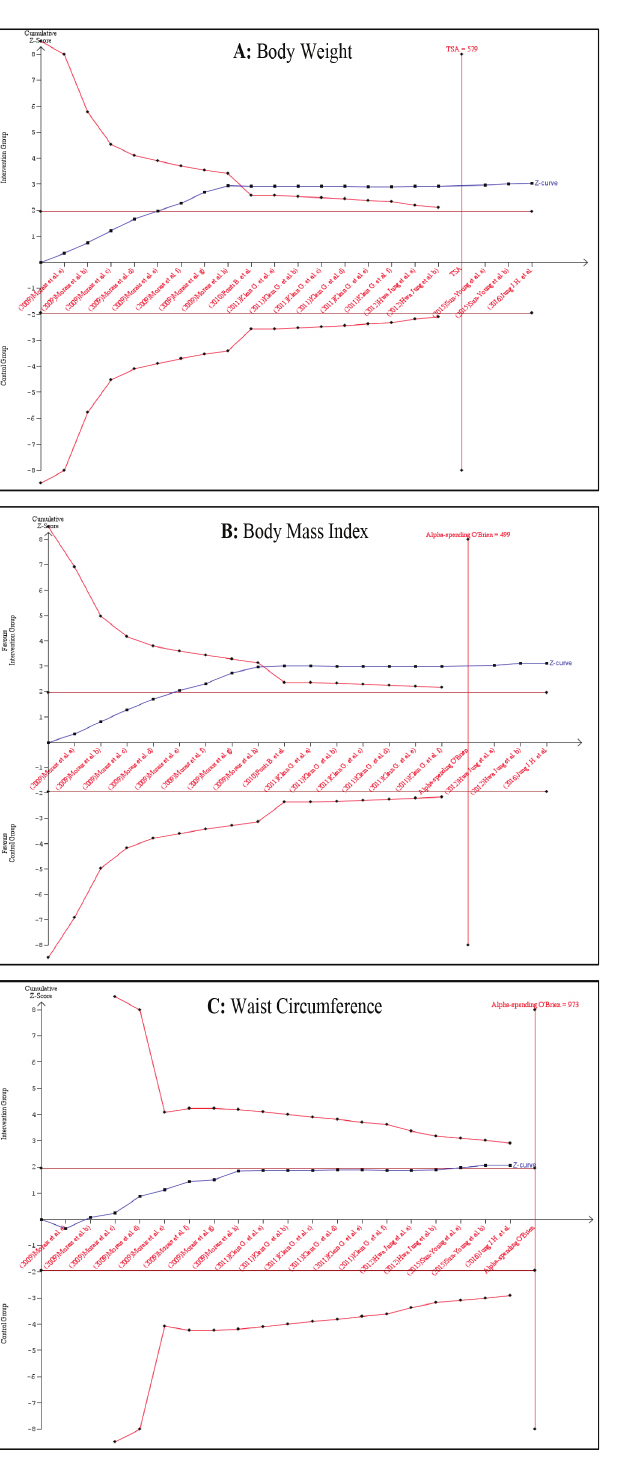
FIGURE 4 - Trial Sequential Analysis (TSA) on pooled results of the effects of I. paraguariensis consumption on the anthropometric measurements considered in this meta-analysis.